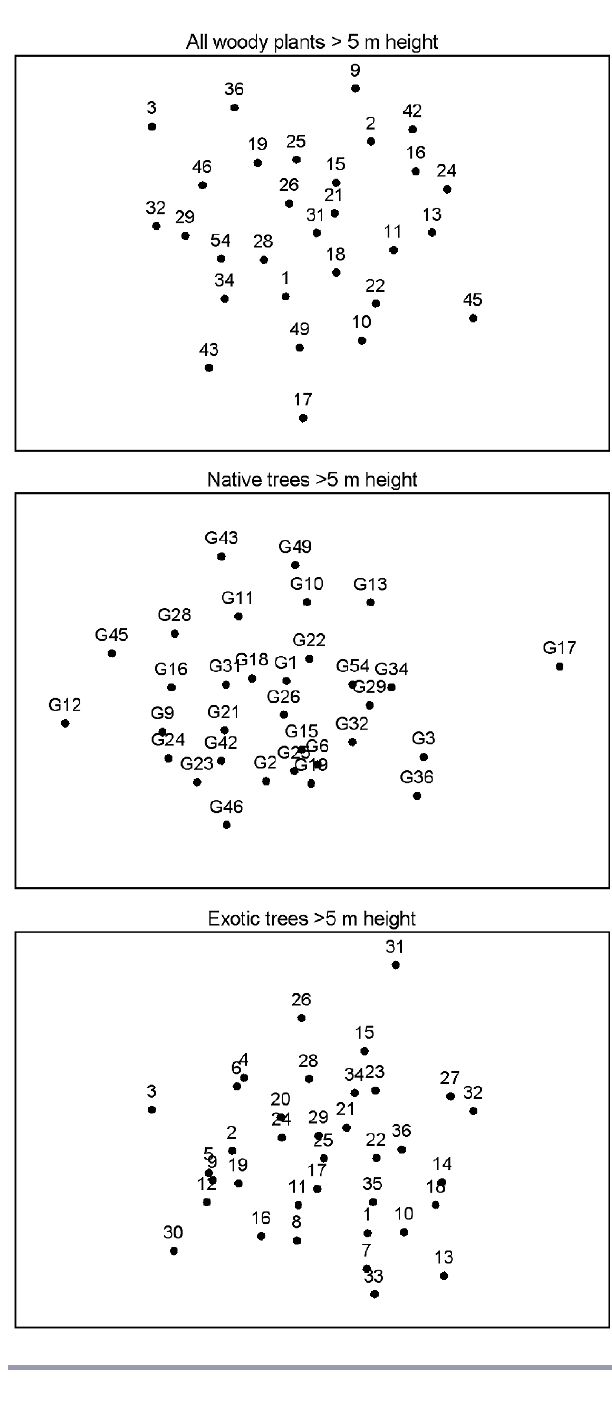
Fig. 5 . Multidimensional scaling (MDS) ordination on trees taller than 5 m: all (stress = 0.17), native (stress = 0.16), and exotic (stress = 0.24) in 55 gardens in Dunedin. Garden numbers are indicated on the plot. Gardens lacking trees of this height were